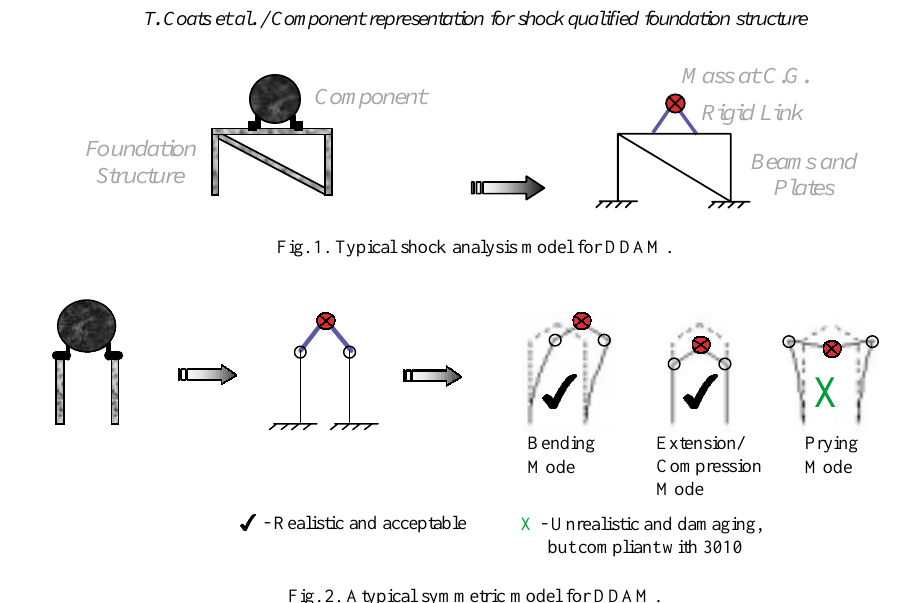
Fig. 2. Atypical symmetric model for